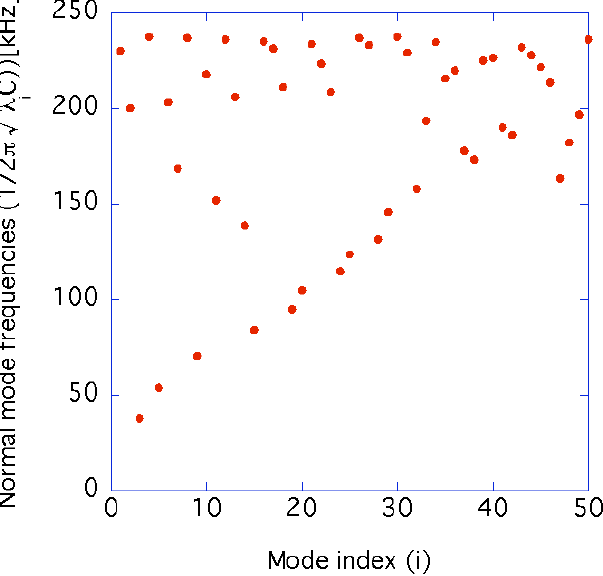
FIG. 32. (Color) The N= 2 normal mode frequencies ffiffiffiffiffiffiffiffi p C (cid:4) ) where i is mode index. These frequencies are ( 1 = 2 (cid:1) i much higher than the inverse of ramping time 1 =T ð¼ 50 Hz Þ . It may be considered that the original magnetic field is consid- ered to have been adiabatically excited when compared with the eigenmode frequencies of the